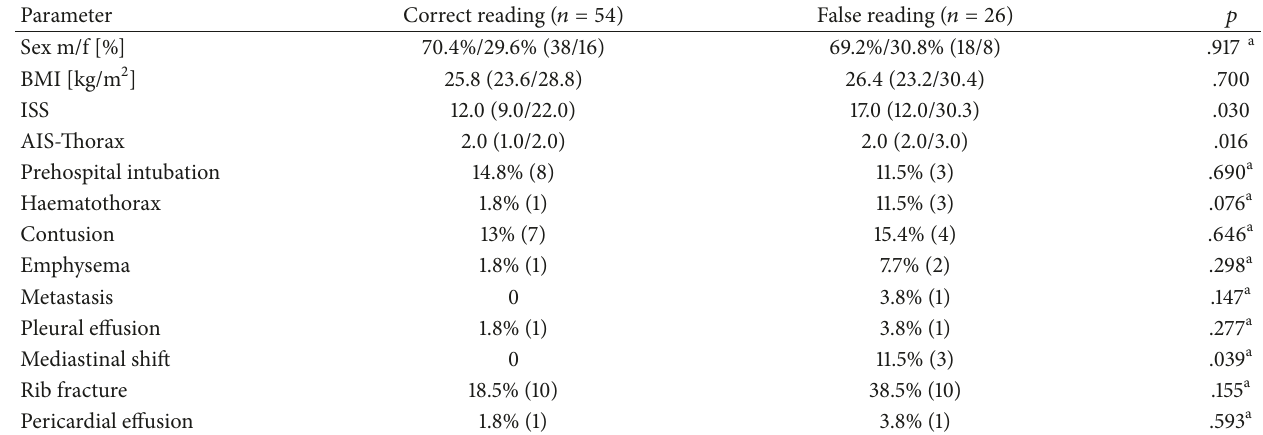
Table 5: Potential biases of PneumoScan-readings . All parameters are presented in relative and absolute values, or as median with 25th/75th percentile. BMI: Body Mass Index; ISS: Injury Severity Score; AIS: Abbreviated Injury Scale. The significant value 𝑝 was calculated with Mann–Whitney 𝑈 Test. a